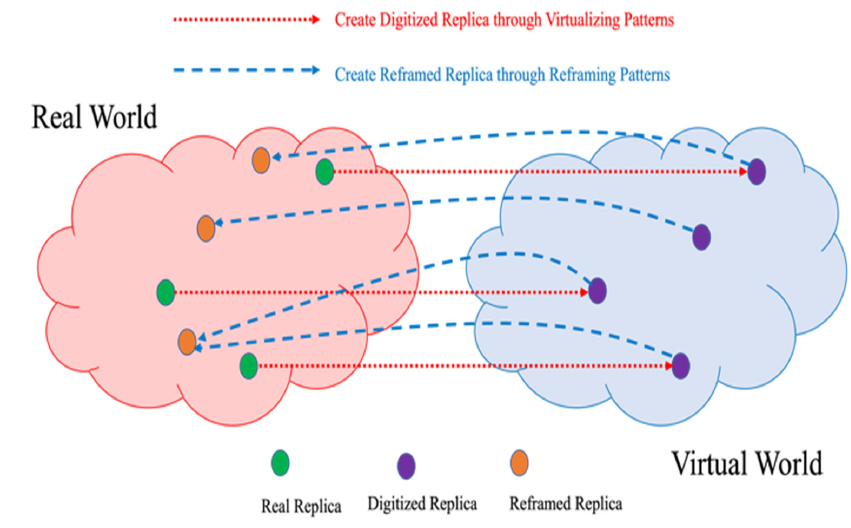
Figure 3. Overview of Virtualizing/Reframing Twin Model.